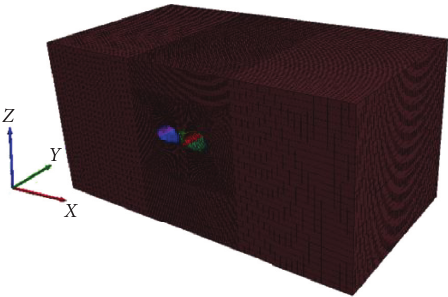
Figure 11: Three-dimensional model